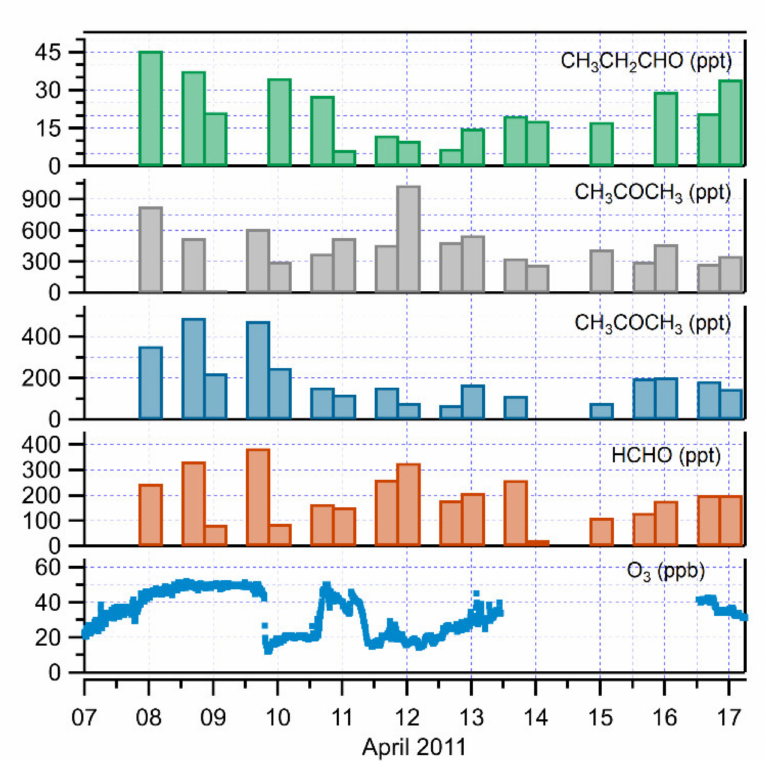
Figure 5. Time series of carbonyl compounds together with O 3 concentrations from 7 to 17 April 2011 at